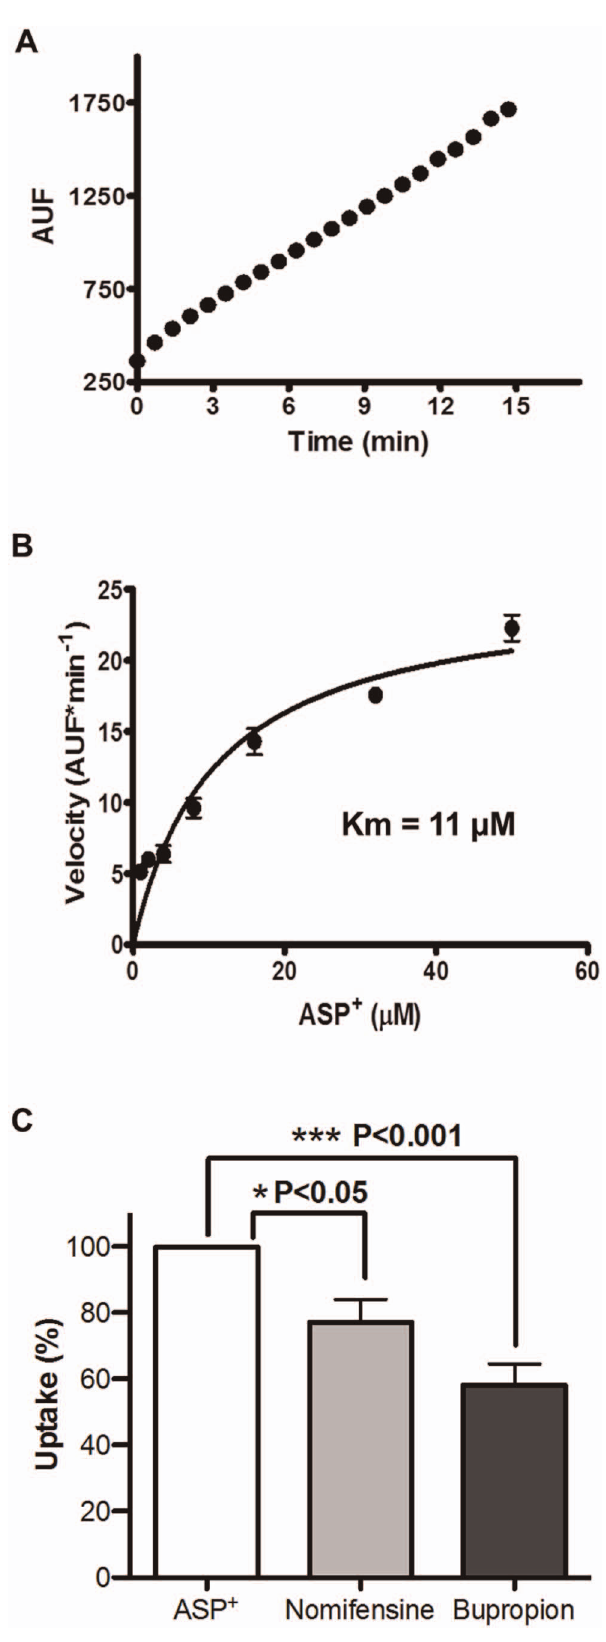
After having established the presence of a dopamine transporter at the sperm surface, the effect of high concentrations of dopamine (0.01, 0.1 and 1 mM) on sperm cell viability, acrosomal integrity and sperm motility were evaluated at three incubation times. The results obtained at 1, 3 and 6 hours did not reveal significant changes in sperm viability at the different concentrations of dopamine used (Figure 3A). The effect of high dopamine doses on acrosomal integrity of ejaculated sperm was also investigated. Sperm exposed to increasing doses of dopamine (0.01, 0.1 and